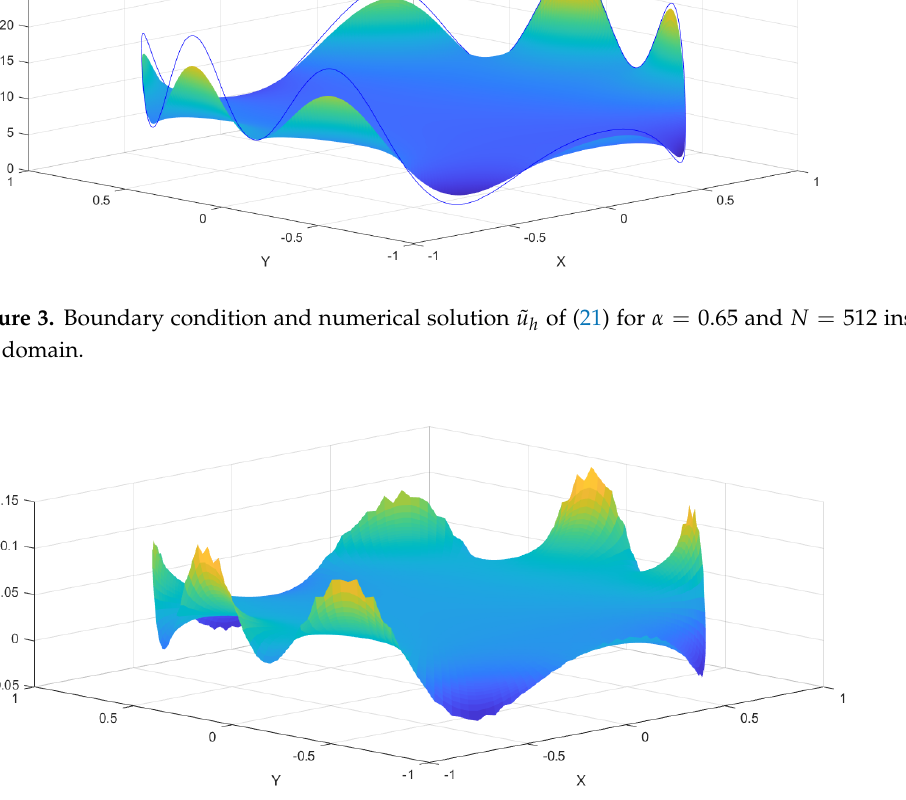
Figure 4. Pointwise error of the numerical solution ˜ u h of (21) for α = 0.65 and N = 512 inside the boundary. We can observe that the error is significantly larger than in the case of α = 0.75.